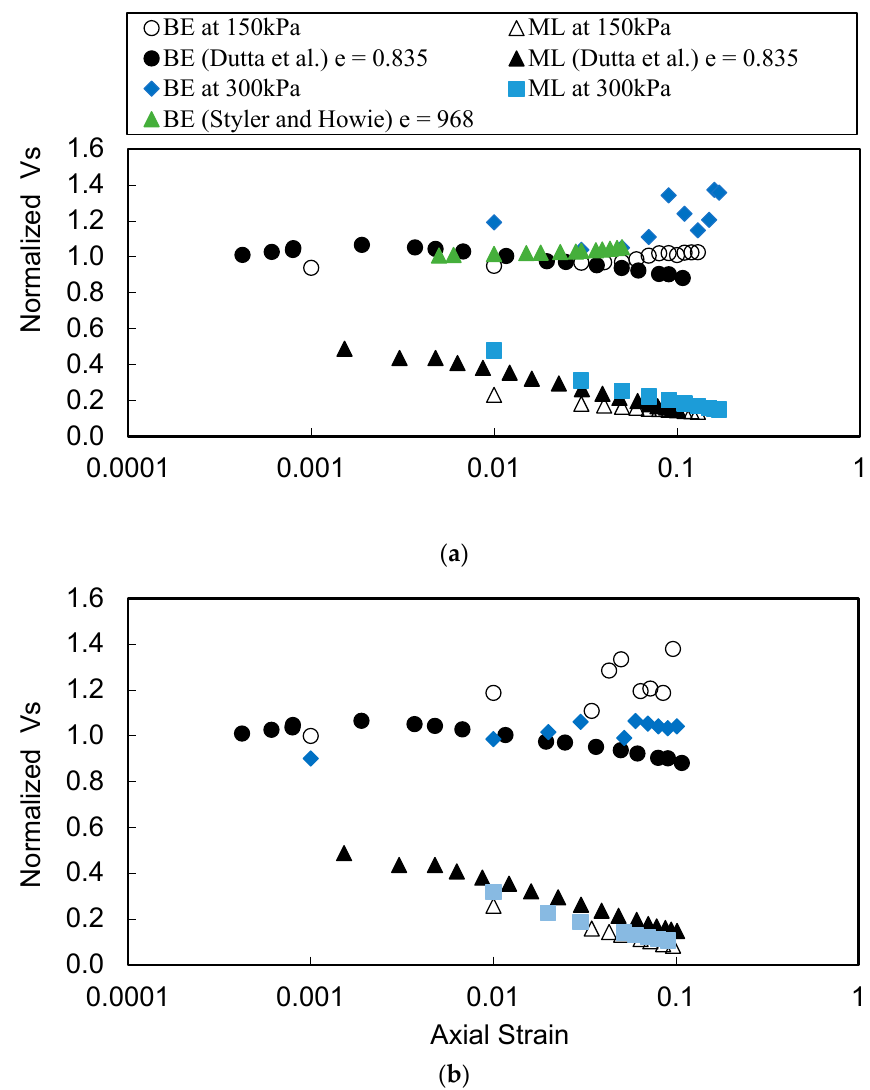
Figure 9. Comparison of results from this study with the results from Dutta et al. [8]; Styler and Howie [9] ( a ) sample A and ( b ) sample B.